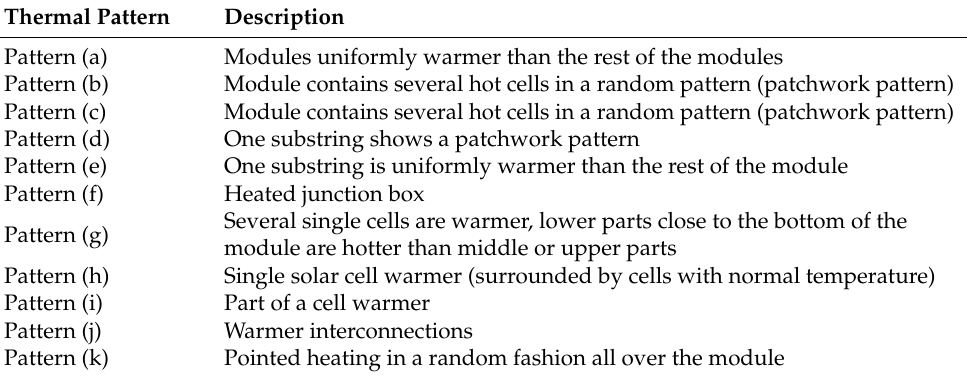
Table 2. Definition of thermal abnormalities investigated in 89 of 95 PV modules of the